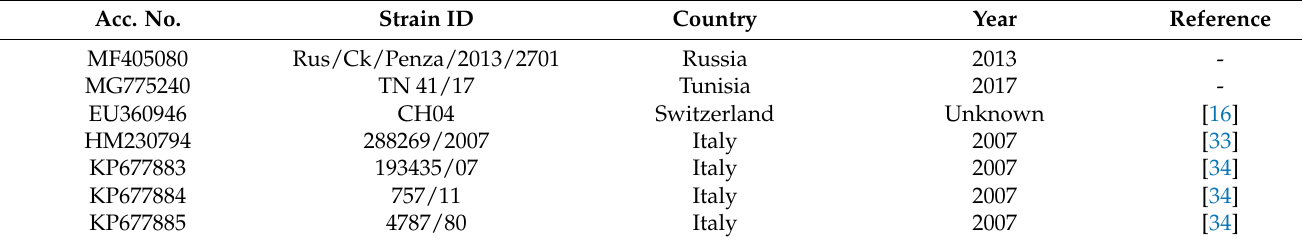
Table 1. The list of sequences from GenBank which are identical with the Greek strain based on the TK gene sequence. Acc.